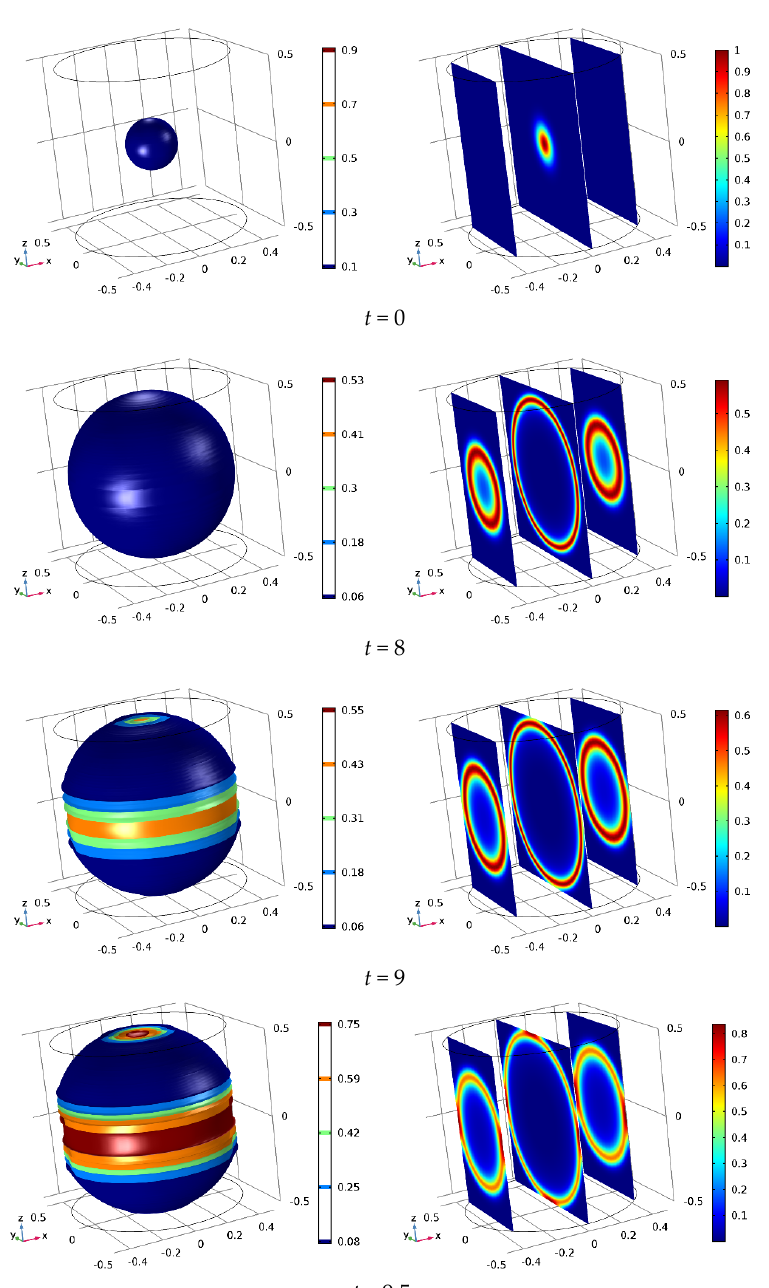
Figure 1. Cancer cell distribution inside the simulated domain during the time evolution, without applied electric field. ( first column ) three-dimensional (3D) iso-surface plots; ( second column ) Slices cutting the plots of the first column along planes normal to the x direction. Snapshots taken at t = 0, t = 8, t = 9, and t = 9.5. In Figure 2, the plot of the reciprocal of the time step size versus the time step of the time-dependent solver is shown, providing the goodness of mesh convergence. The re- sults of convergence plots relative to subsequent simulations, being quite similar, are not shown.